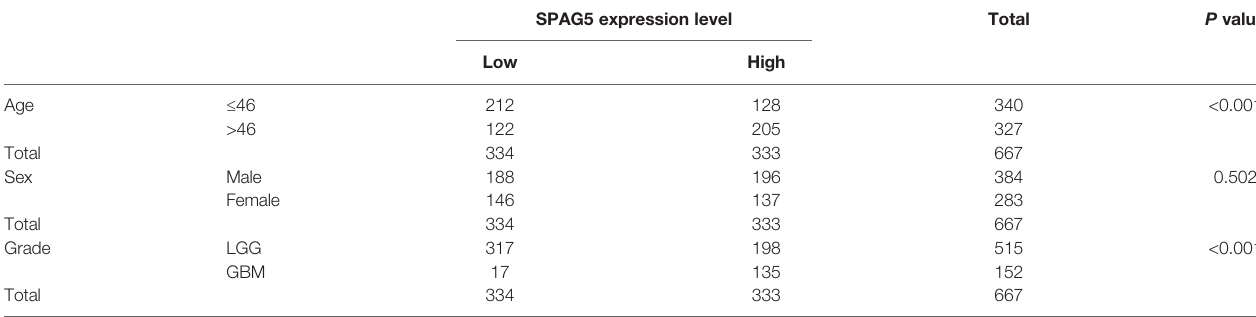
TABLE 1 | The relationship between SPAG5 expression level and clinic characteristics in glioma